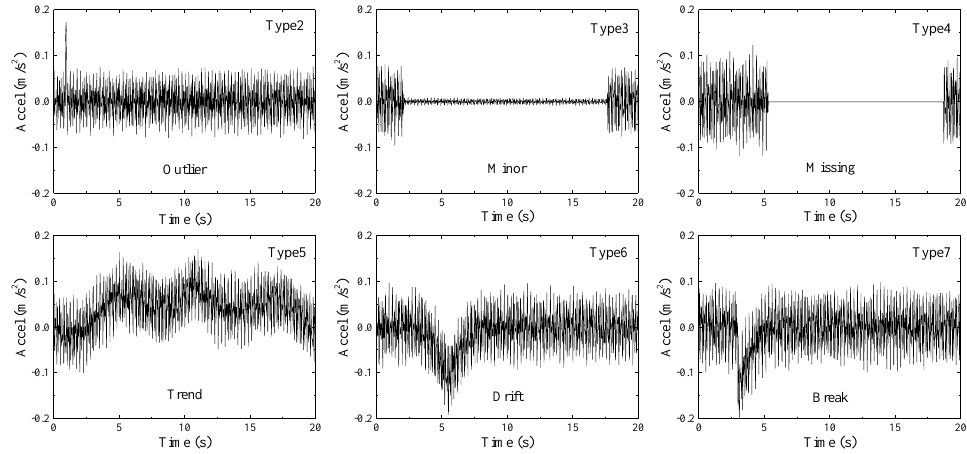
Figure 4. Six typical anomaly patterns of acceleration data.